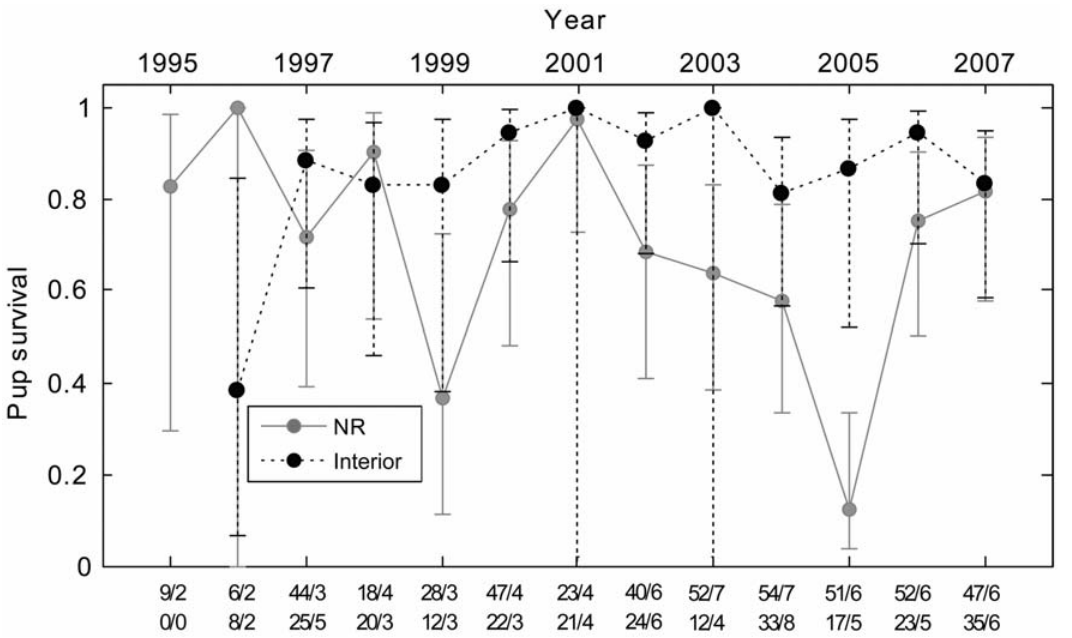
Figure 3. Annual wolf-pup survival in Yellowstone National Park by location (Northern Range [NR] and Interior), 1995–2007. Error bars are 95% confidence intervals and the numbers at the bottom of the graph represent the number of pups monitored/the number of packs observed (NR listed on top).